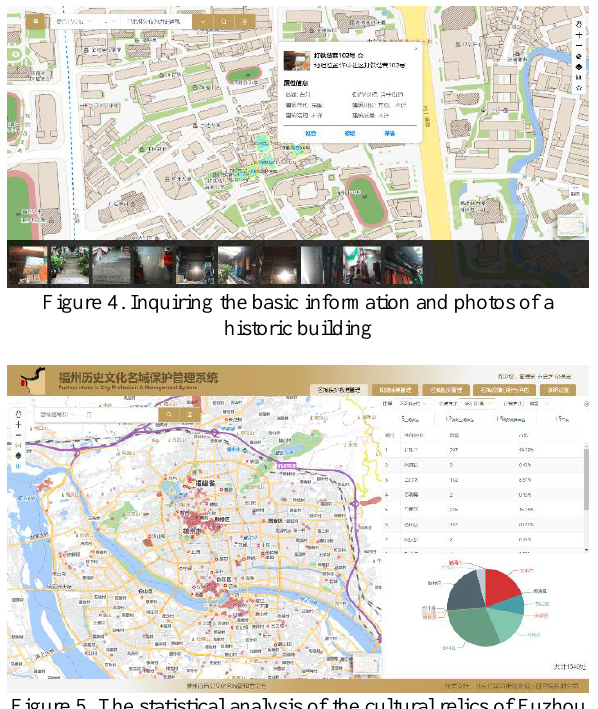
Figure 7. App for historic sites survey on iPad